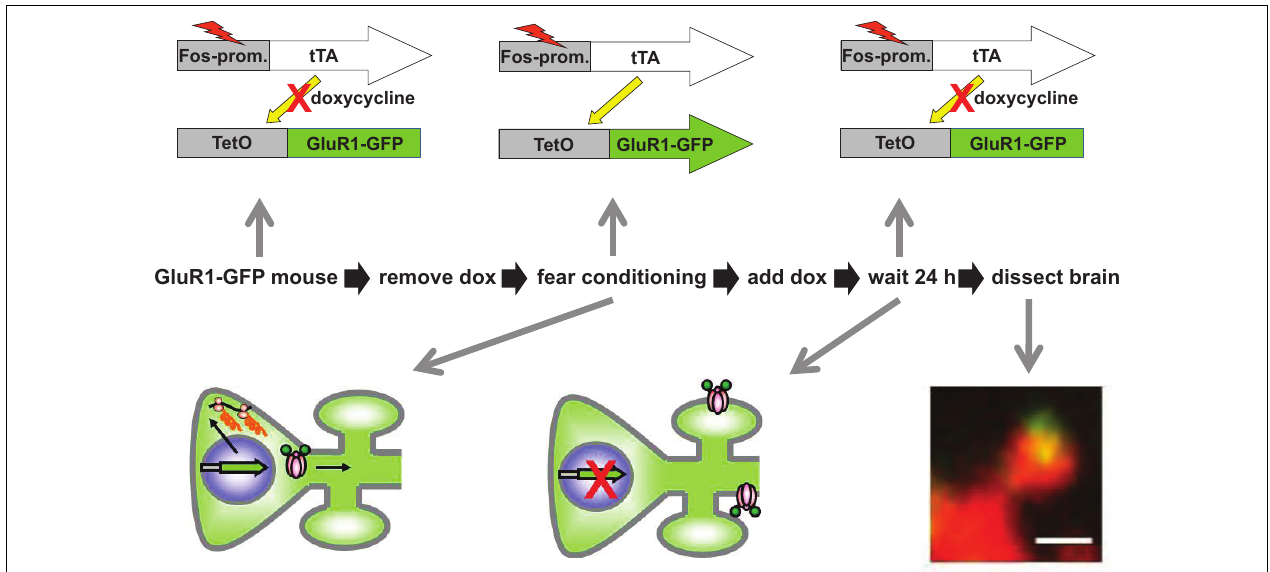
of GFP-GluR1 expression in active neural ensembles in the hippocampus. The distribution of GFP-GluR1 in dendritic spines was analyzed 24 h following the conditioning using DiI to label all spines on a given neuron. Fear conditioning led to an increase in traffi cking of the receptor specifi cally to mushroom type spines. This experiment demonstrates how genetic tools can be used to image a specifi c molecular event selectively within an activated neural